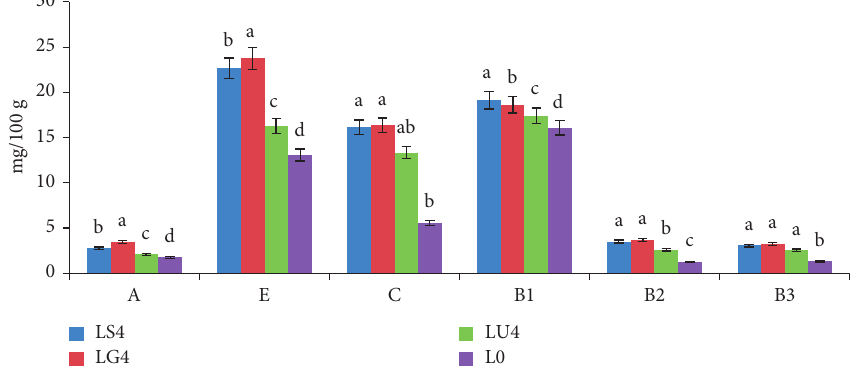
Figure 3: Vitamin content of fruit paste with 3% algae powder. Different letters indicate significant differences ( p < 0 . 05 )